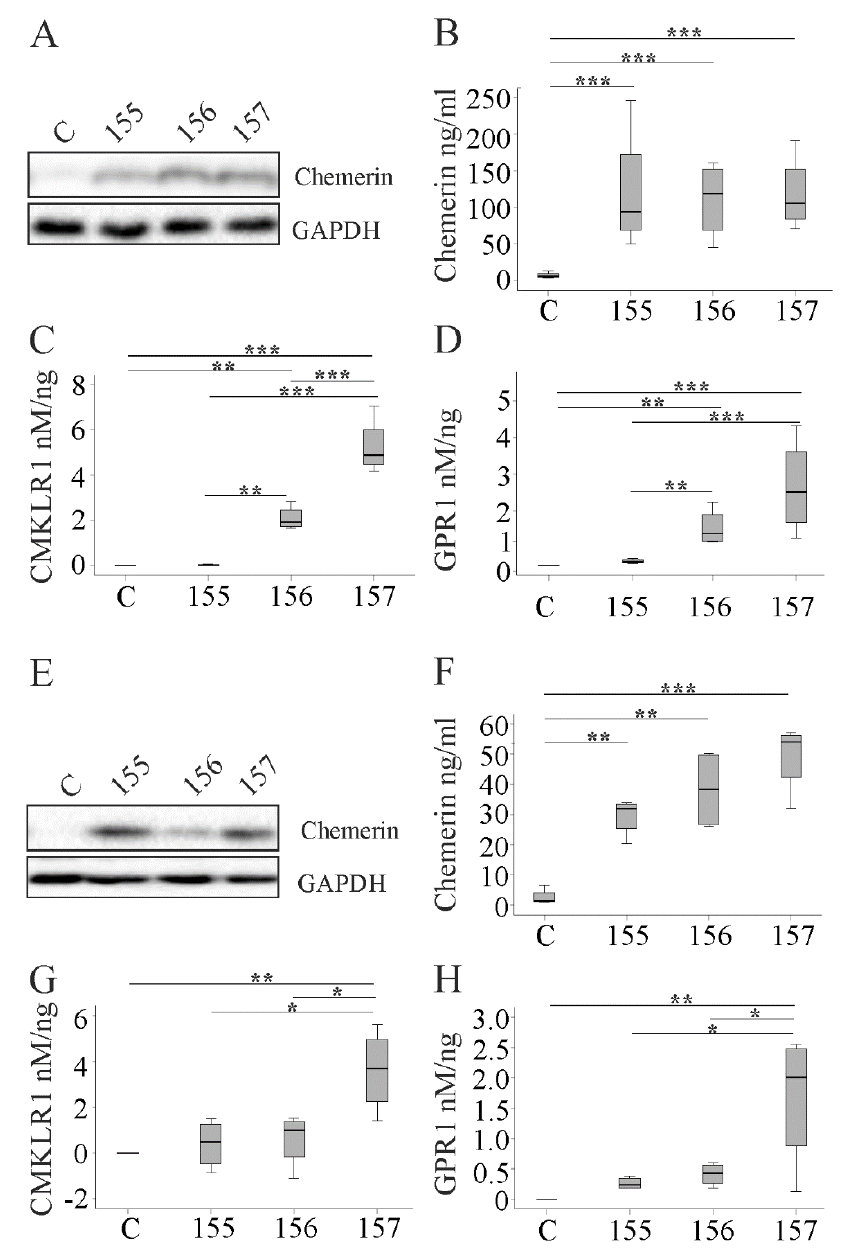
Figure 2. Expression of chemerin isoforms in HepG2 and Huh7 cells. ( A ) Immunoblot of chemerin in the cell lysate of HepG2 cells expressing huChem-155, -156 or -157. C indicates HepG2 cells transfected with the insertless plasmid. ( B ) Quantification of secreted chemerin in the media of HepG2 cells by ELISA. Activation of ( C ) human CMKLR1 or ( D ) human GPR1 by the human chemerin isoforms relative to total HepG2 media chemerin levels. ( E ) Immunoblot of chemerin in the cell lysate of Huh7 cells expressing huChem-155, -156 or -157. C indicates Huh7 cells transfected with the insertless plasmid. ( F ) Quantification of secreted chemerin in the media of Huh7 cells by ELISA. Activation of ( G ) human CMKLR1 or ( H ) human GPR1 by the chemerin isoforms relative to total Huh7 media chemerin levels. Data were analyzed with one-way ANOVA with post-hoc Tukey test. * p < 0.05; ** p < 0.01; *** p < 0.001; n = 4.